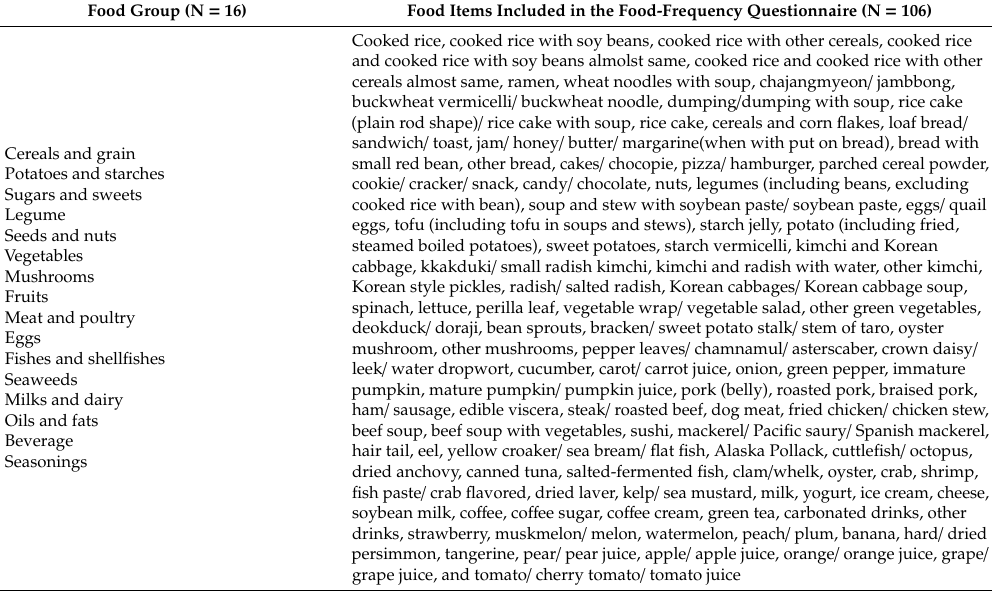
Table A2. Food groups used to construct the network of dietary